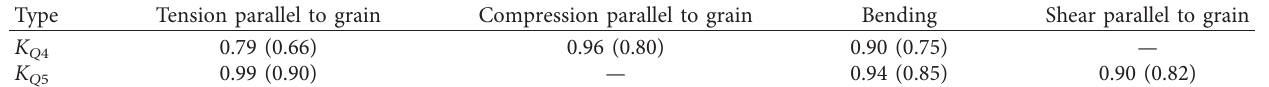
Table 2: The adjustment coefficient of natural defect and coefficient of dry defect.